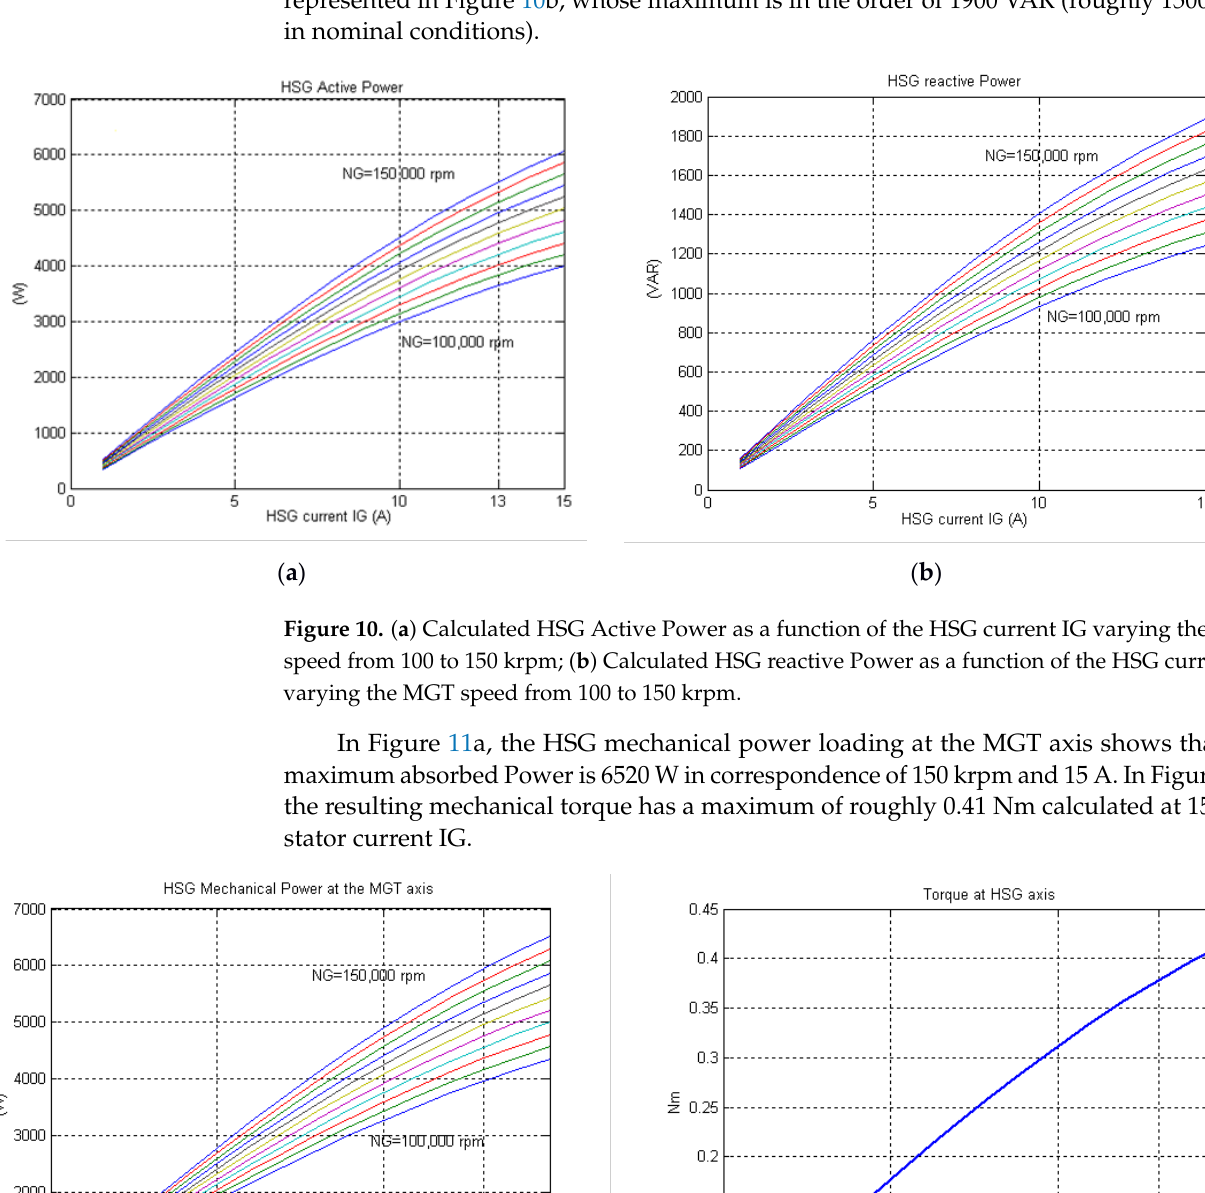
Figure 9. ( a ) Calculated power to the grid as a function of the Generator Current IG varying the MGT speed from 100 to 150 krpm; ( b ) Calculated current injected to the grid a function of the Generator Current IG varying the MGT speed from 100 to 150 krpm.